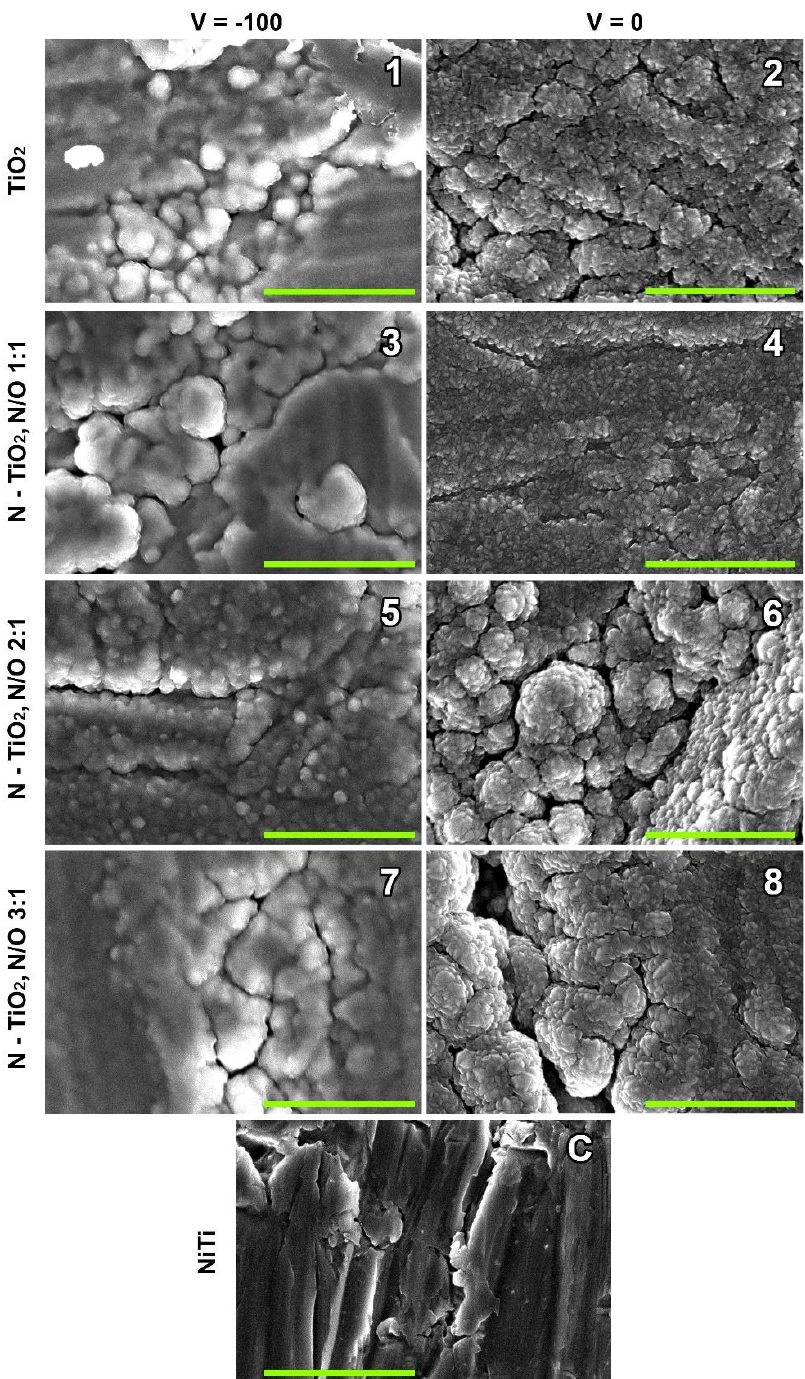
Figure 1. Samples Nos. 1 – 8 are TiO 2 - or TiO x N y -coated NiTi surfaces (the numbering is identical to that in Table 1). Sputtering was carried out at −100 V (left column) or 0 V (right column). The bottom that in Table 1). Sputtering was carried out at − 100 V (left column) or 0 V (right column). The bottom image ( c ) presents the bare nitinol surface. Scale bars are 1 μm. image ( c ) presents the bare nitinol surface. Scale bars are 1 µ